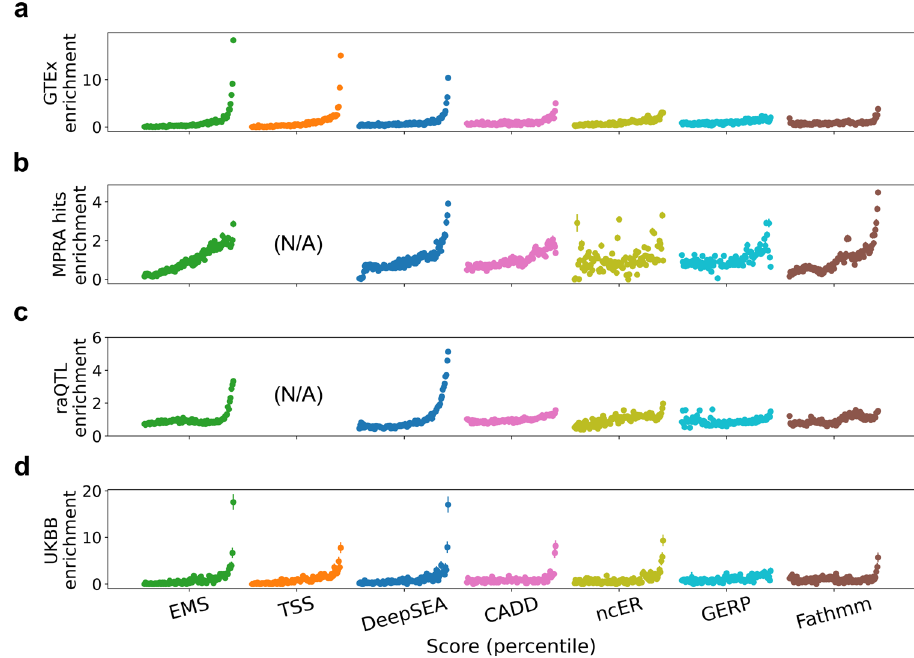
Fig. 3 Performance evaluation of EMS. Comparison of the different scoring methods in prioritizing putative causal whole-blood eQTLs in GTEx v8 ( a ), massive parallel reporter assay (MPRA) saturation mutagenesis hits 12 ( b ), reporter assay QTLs 40 (raQTLs) ( c ), and putative hematopoietic-trait causal variants in UKBB ( d ) in different score percentiles.